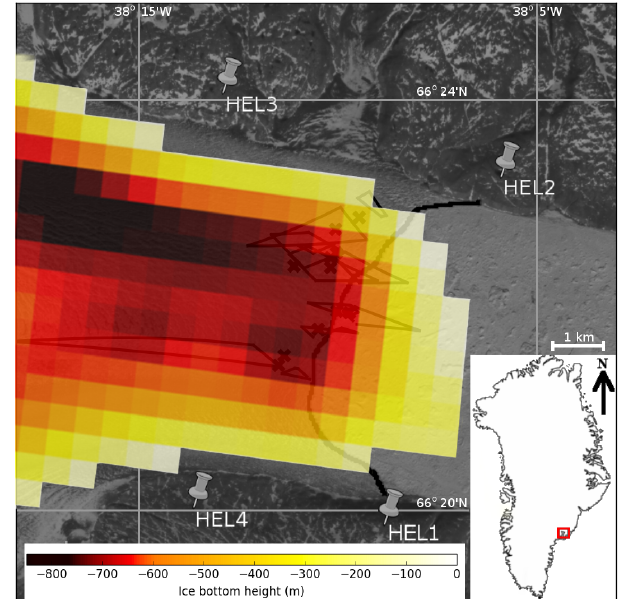
Figure 9. The calving events from Fig. 7 overlain with the bedrock topography from the Multichannel Coherent Radar Depth Sounder (MCoRDS) L3 data set from NSIDC (Leuschen and Allen, 2013), with the calving front from 9 July 2015 in black. The topography is collated and averaged from 2008 to